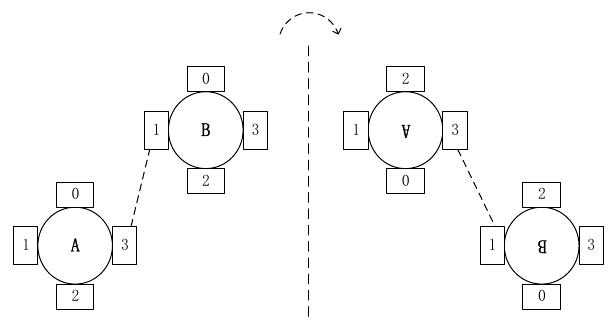
Figure 2. Satellite link establishment status in different hemispheres.